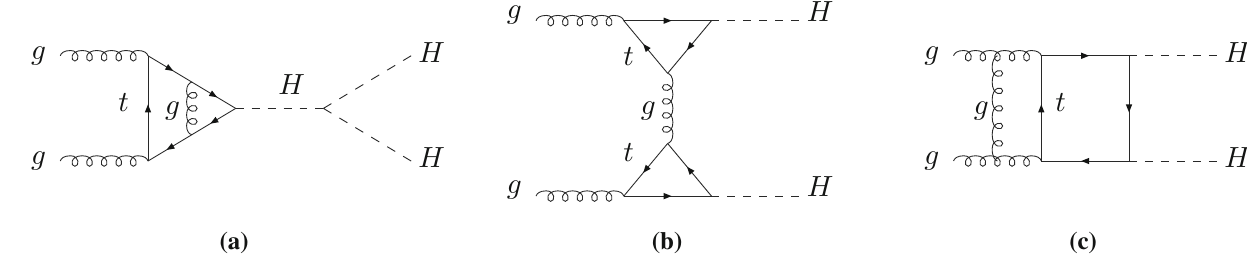
Fig. 1 Typical two-loop diagrams contributing to Higgs-boson pair production via gluon fusion: a triangle diagram, b one-particle reducible diagram, c box